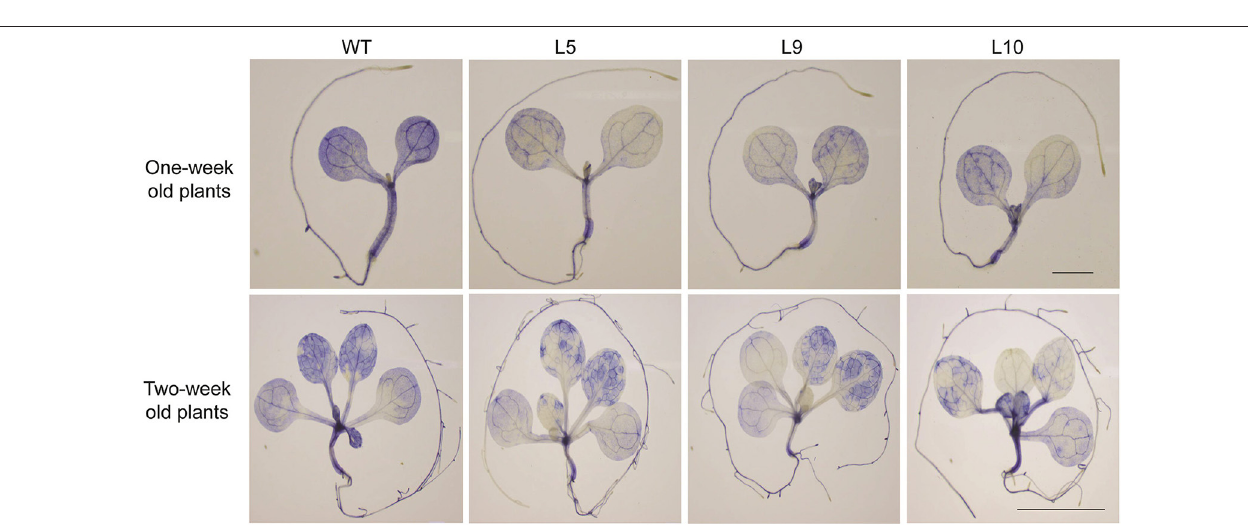
Frontiers in Plant Science |